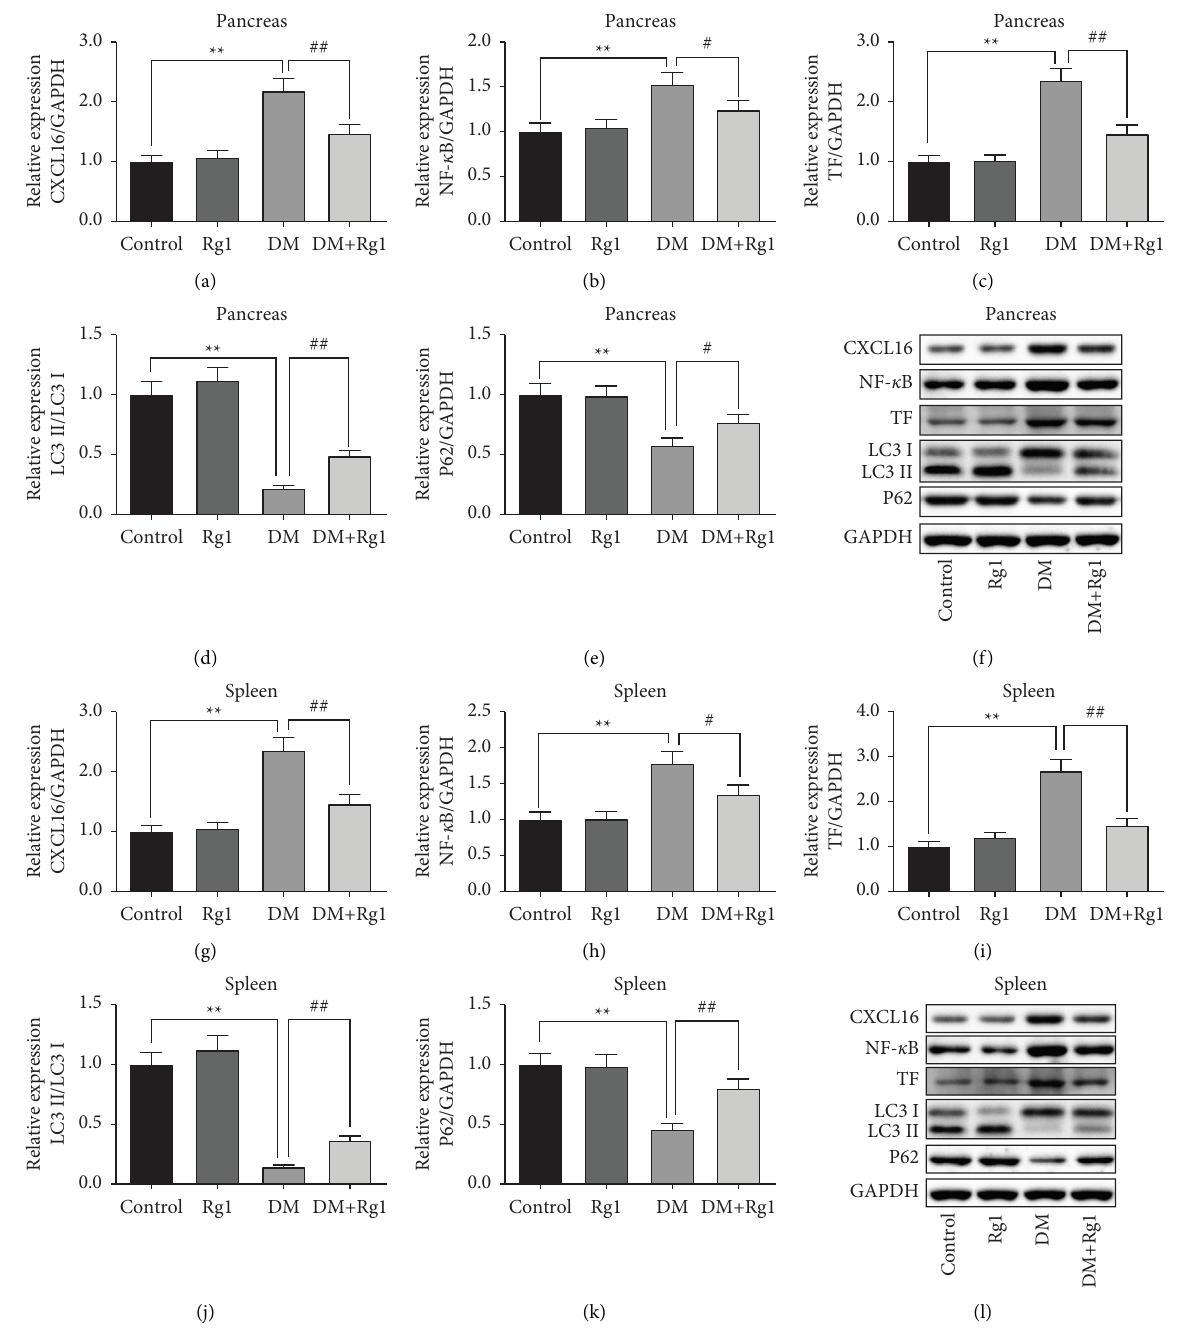
Figure 8: Te expression of CXCL16, NF- κ B, TF, LC3, and P62 proteins in the pancreas and spleens. (Mean ± SD, n � 3) (a–f) the expression of CXCL16, NF- κ B, TF, LC3, and P62 proteins in the pancreas. (g–l) Te expression of CXCL16, NF- κ B, TF, LC3, and P62 proteins in the spleens. Te improvement of Rg1 treatment on type 1 diabetes mice was related to the increase of CXCL16, NF- κ B, and TF and the raised autophagy (IL3 II/LC 3 I). ∗∗ p < 0 . 01, vs. the control group; ns p > 0 . 05, ## p < 0 . 01 vs . the DM